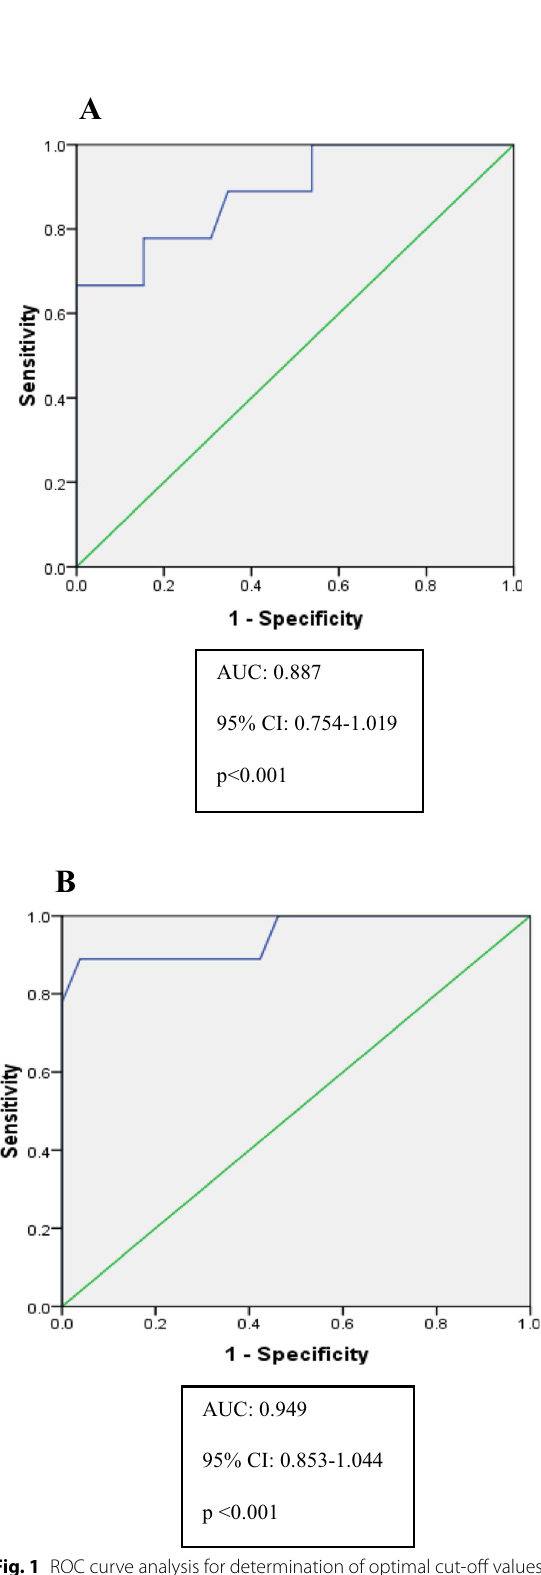
Fig. 1 ROC curve analysis for determination of optimal cut-off values for pre-operative plasma fibrinogen ( A ) and D-dimer ( B